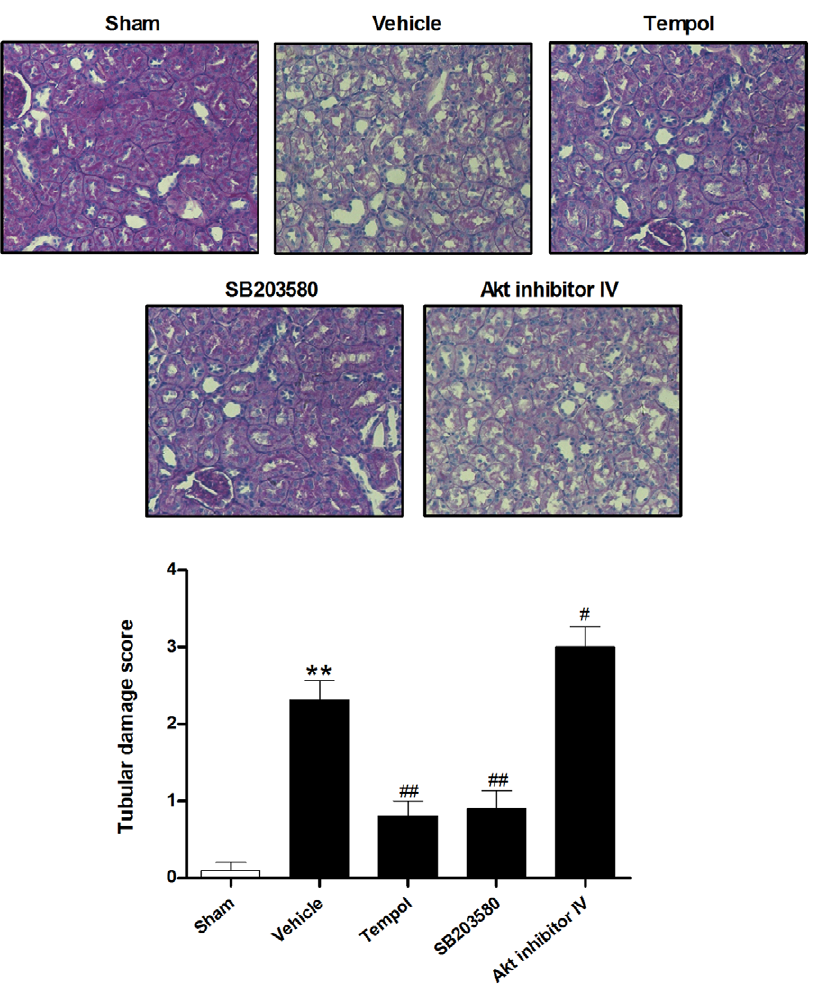
Figure 2. Histopathological renal injury in rats at 72 h after burn. Representative images (magnification =200 6 ) showed the histological examination for tubular damage with different treatments postburn using periodic acid–Schiff (PAS) staining. The data indicated burn induced significant renal damage at 72 h, which was improved by inhibiting ROS production or p38 MAPK expression, and deteriorated by inhibiting Akt expression. ** P , 0.01 vs. Sham; # P , 0.05, ## P , 0.01 vs. Vehicle. n=6 rats per group per time point.